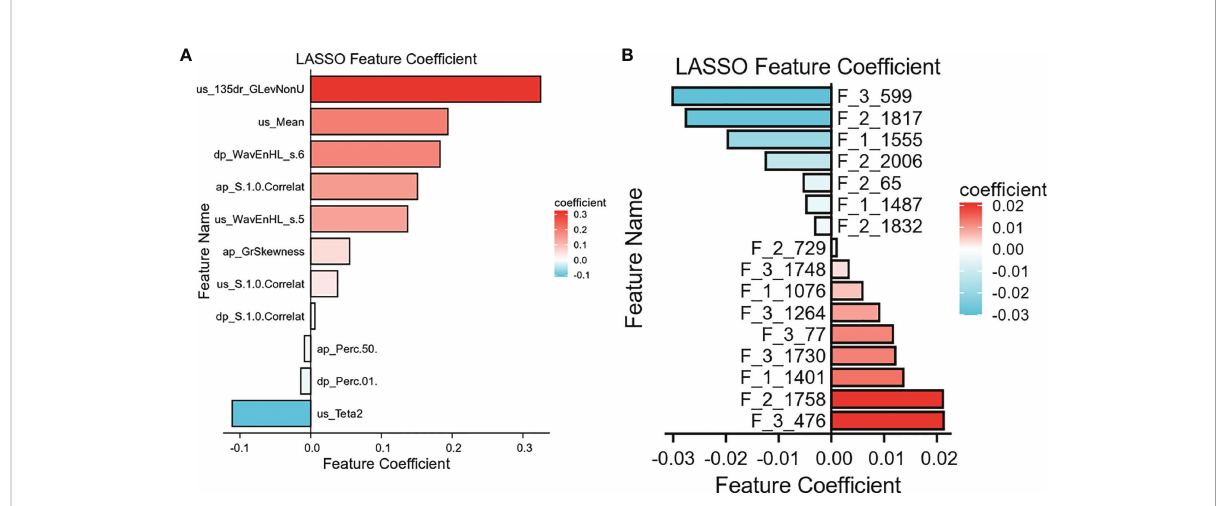
FIGURE 3 Characteristics selected the radiomics and DL model. (A) 11 features and its coef fi cients for the radiomics model. (B) 16 features and its coef fi cients for the DL